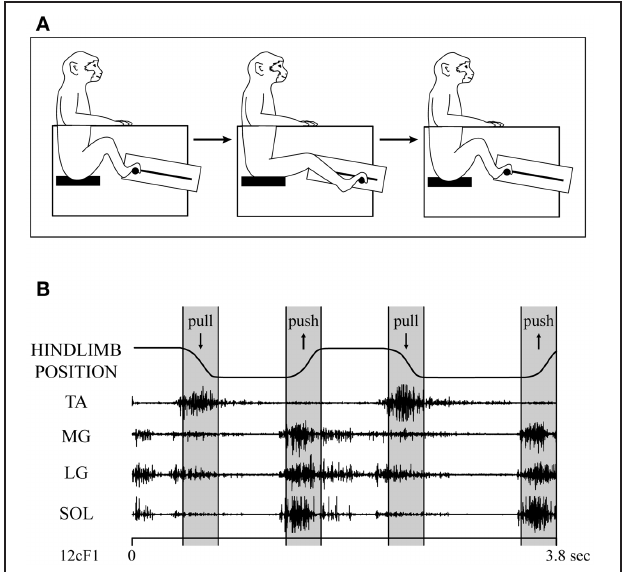
FIGURE 1 | (A) Hindlimb push-pull task. The monkey is seated in a custom-built primate chair with both arms and the left leg restrained. The monkey gripped the push-pull device’s manipulandum (horizontal post) with the right foot and pushed it to a target zone. After a hold period of 500ms in the target zone, the monkey pulled the manipulandum to a second target zone and held for 500ms. Upon successful completion of each push-pull trial, the monkey was given an applesauce reward. The behavioral task was guided by visual and auditory cues. (B) EMG records of ankle muscles during two cycles of the hindlimb push-pull task. TA, tibialis anterior; MG, medial gastrocnemius; LG, lateral gastrocnemius; SOL, soleus. Figure adapted from Hudson et al.